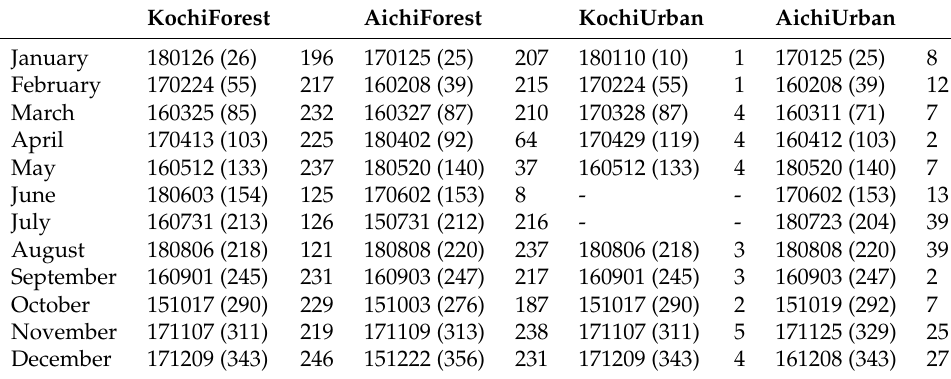
Table 3. Selected dates for the top MODIS data evaluated by the number of confident clear pixels over each ROI. Dates are represented by six characters, “YYMMDD” (Y, M, and D represent the year, month, and day, respectively). The number in parentheses is the day of the year. The third, fifth, seventh, and ninth columns show the number of pixels found to be confident clear in each